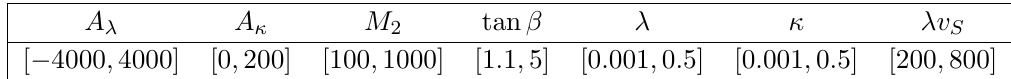
Table 2 . Sample ranges for the scanned NMSSM parameters. All dimensionful numbers are in GeV. M 1 was (cid:12)xed to 500 GeV. The modest range of tan (cid:12) was to help satisfy (cid:13)avour constraints. Sfermions were decoupled by setting the (cid:12)rst and second generation squark masses to 6 TeV and the third generation to 3 TeV.